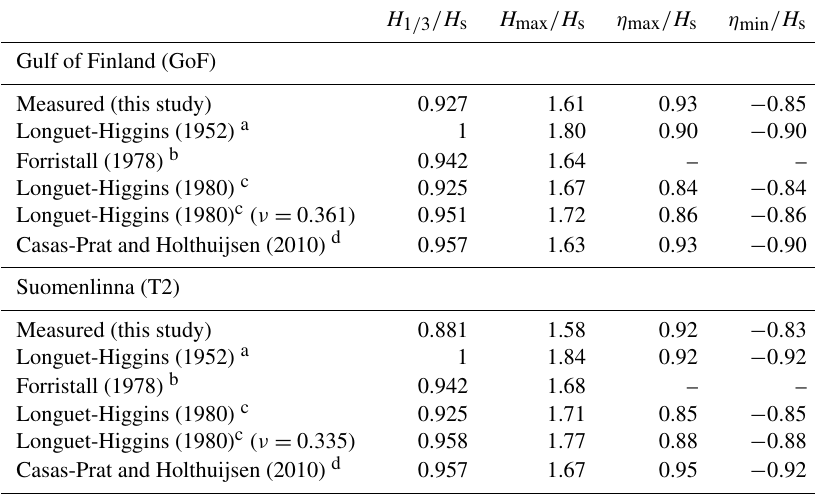
Table 3. The different wave height and crest height parameters at the Gulf of Finland (GoF) and Suomenlinna (T2). The values have been determined using a linear fit through the origin of the P80 data set. The ratio H 1 / 3 /H s was taken as reported in the literature. The single wave statistics for the distributions given in the literature have been determined using the individual number of waves for each wave record and the mean value of the spectral width parameter ν (when